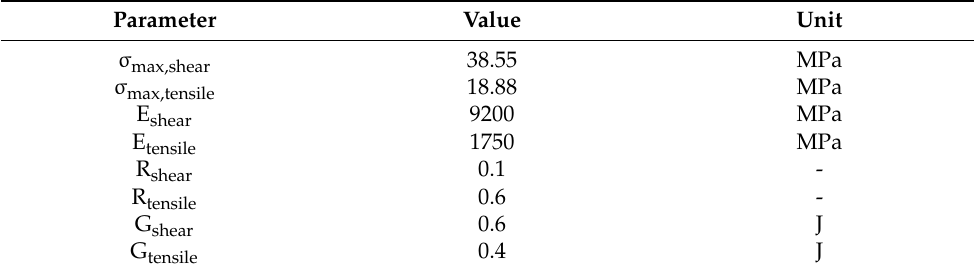
Table 5. Parameters for the cohesive-zone model (distance = 300 µm).